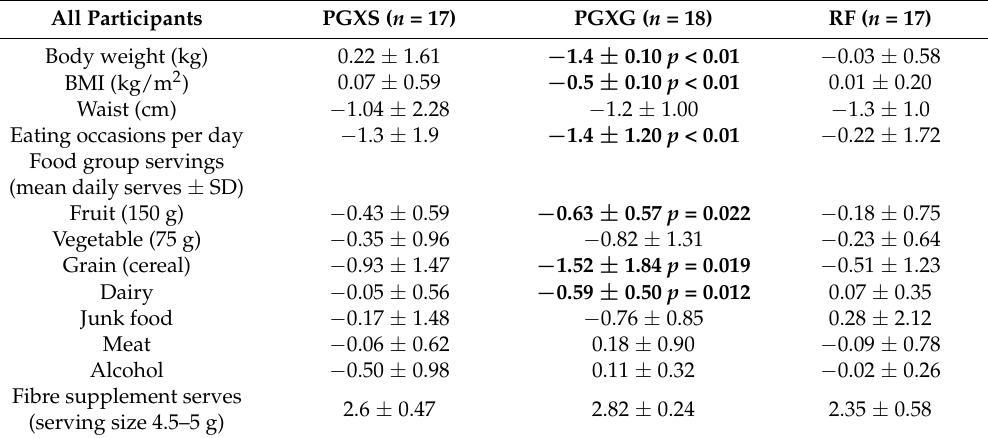
Table 5. Change in participant characteristics from baseline to week 12 of the PGXS, PGXG and RF interventions in the subgroup analysis of those who consumed the recommended dose of fibre supplements (per ‐ protocol analysis).